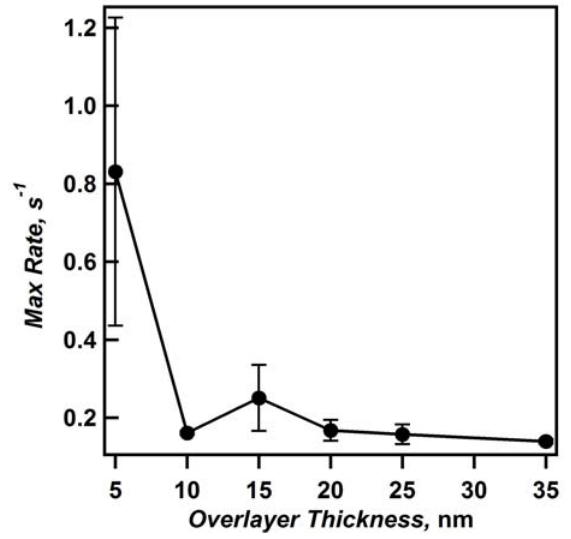
Figure 7. Plot of maximum rate of deswelling for etalons with different overlayer thicknesses. Data averaged from two sets of independently fabricated etalons, with standard deviation shown using error bars. Reprinted with permission from [14] Copyright (2011) American Chemical